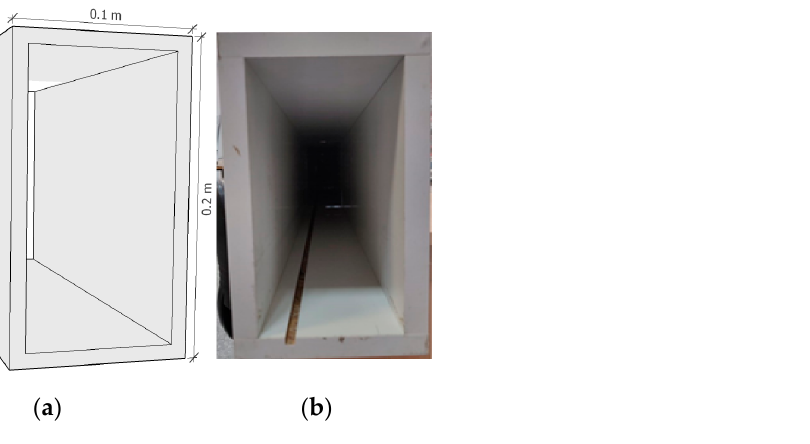
Figure 6. Scale tunnel model built out of Formica of rectangular profile with a height of 0.2 m and width of 0.1 m ( a ) a schema, and ( b ) a real tunnel model.